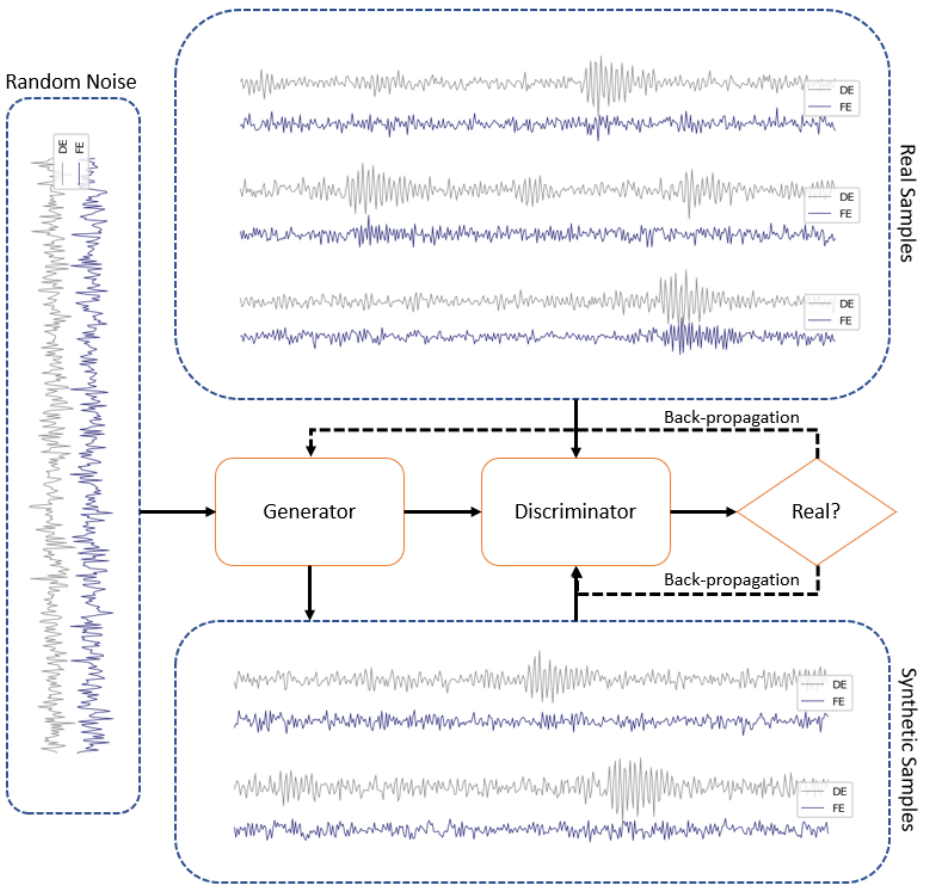
Figure 2. The schematic process in